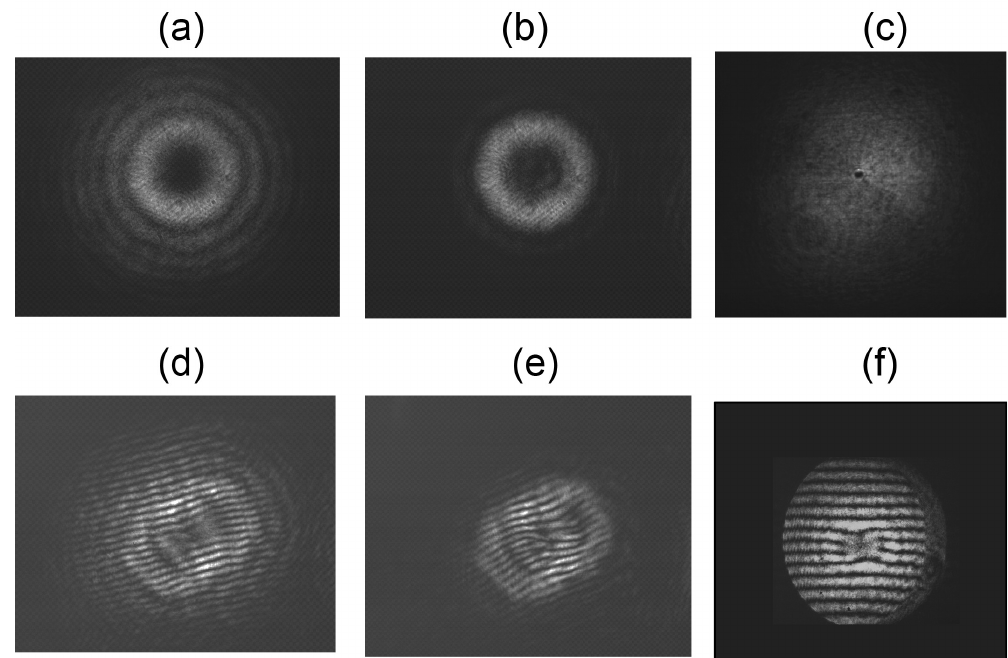
Figure 1. Beam modes ( a – c ) and corresponding shear interferograms ( d – f ) of vortex beams generated using phase modulation only (a,c), phase and amplitude modulation (b) and far-field (a,b) and near-field imaging (c). All modes have (cid:96) = +